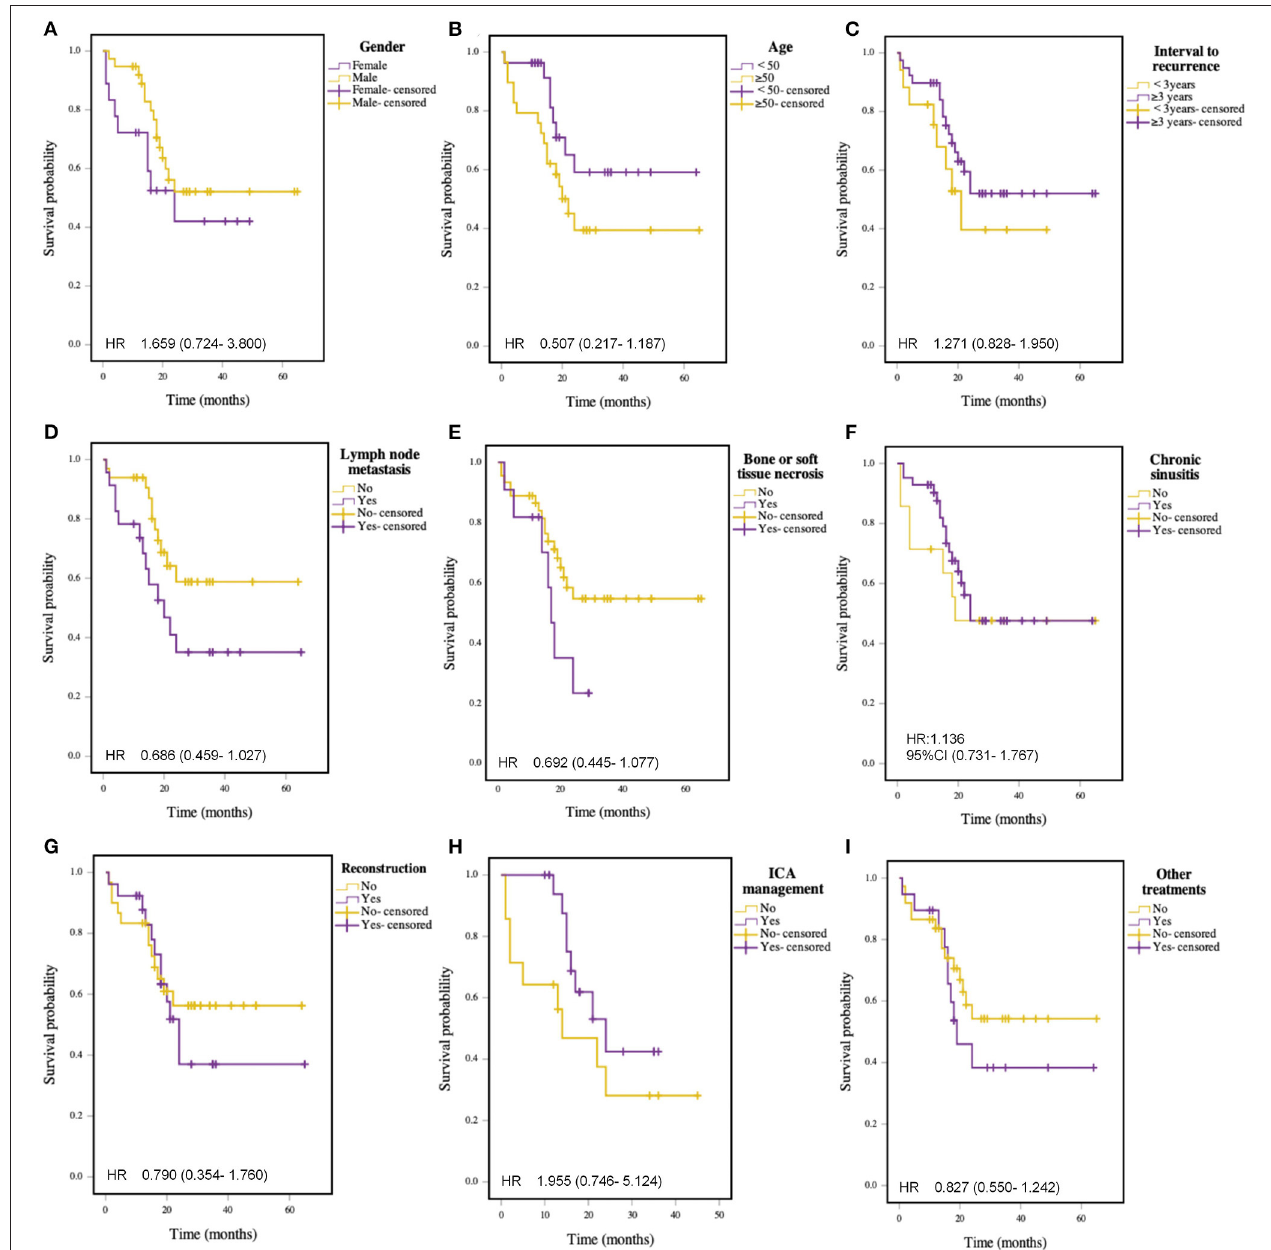
FIGURE 4 | Kaplan-Meier curve for survival in patients with recurrent NPC: (A) Gender; (B) Age ( ≥ 50 vs. < 50 years); (C) Interval of recurrence ( ≥ 3 vs. < 3 years); (D) Lymph node metastasis; (E) Bone or soft tissue necrosis; (F) Chronic sinusitis; (G) Reconstruction; (H) ICA management; (I) Other